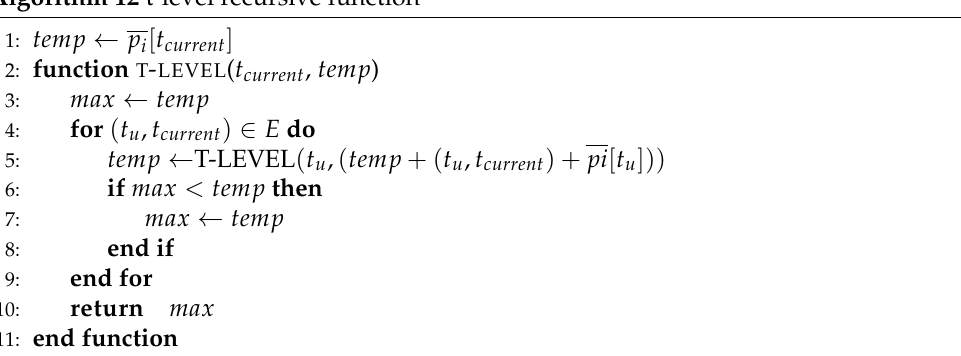
Algorithm 12 t-level recursive function